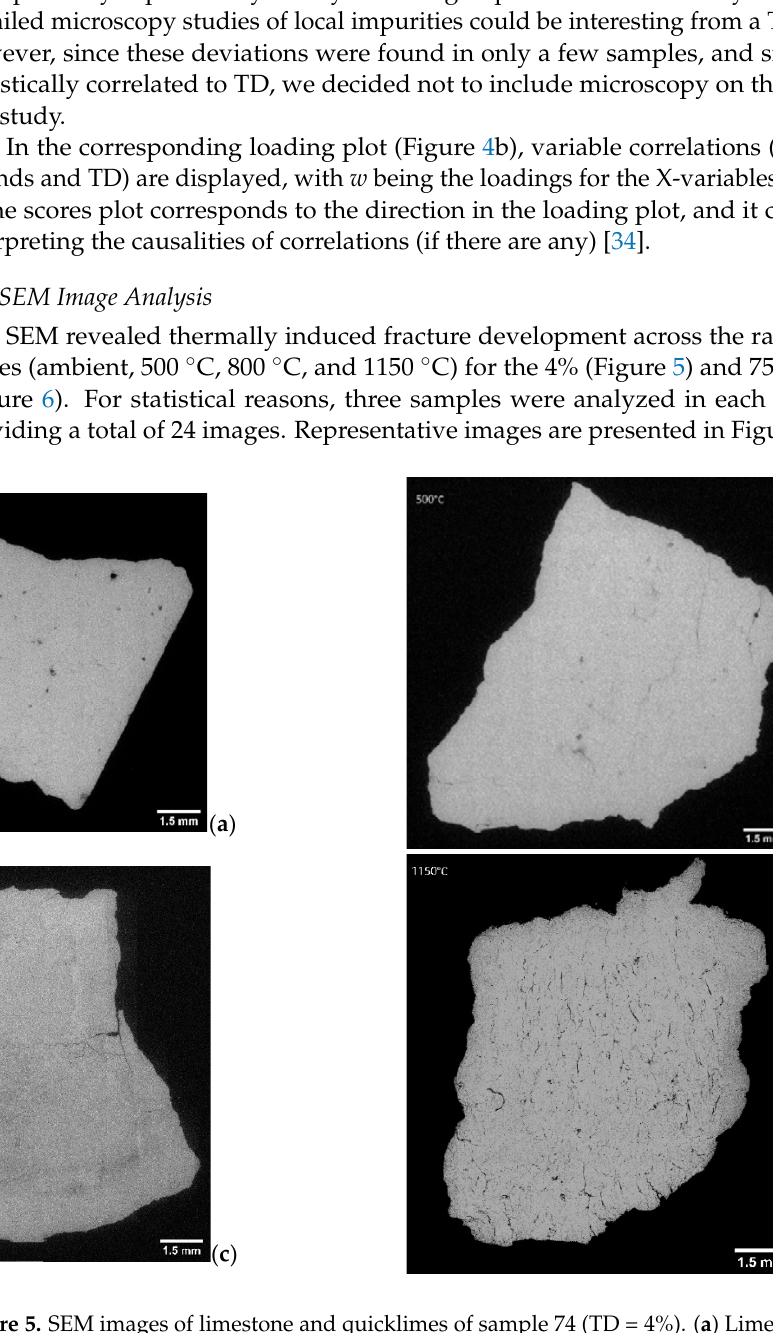
Figure 5. SEM images of limestone and quicklimes of sample 74 (TD = 4%). ( a ) Limestone at ambient temperature, ( b ) heated to 500 ◦ C, ( c ) heated to 800 ◦ C, and ( d ) heated to 1150 ◦